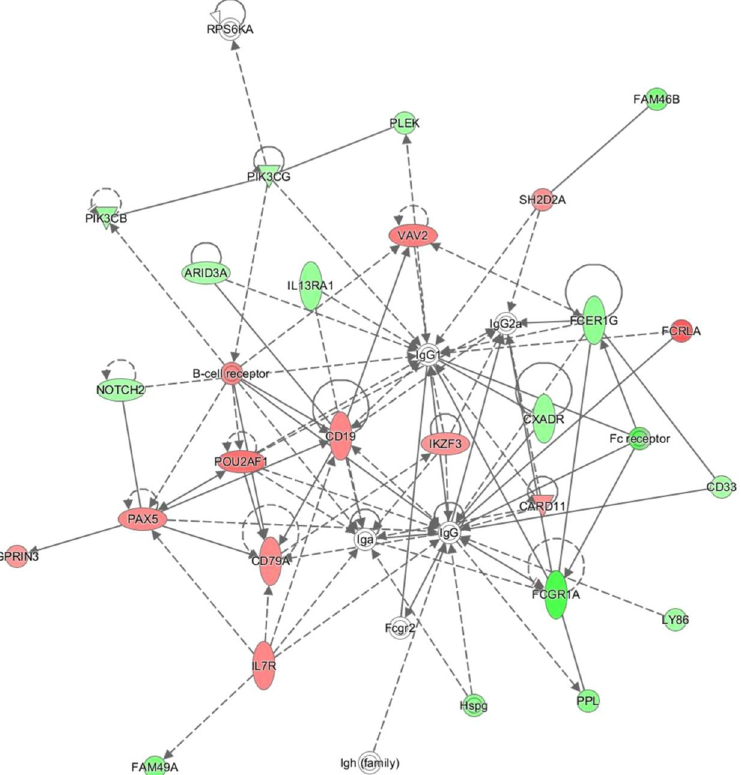
Figure 2. Humoral Immune response network enriched in comparison of Beef LF 168 h v Beef LF 72 h. Network 23- Humoral Immune Response, Protein Synthesis, Cellular Development network enriched in comparison of beef LF 168 h versus Beef LF 72 h. The network is displayed graphically as nodes (genes). The node colour intensity indicates the expression of genes; with red representing up-regulation and green, down- regulation in 168 h beef LF calves compared to 72 h beef LF